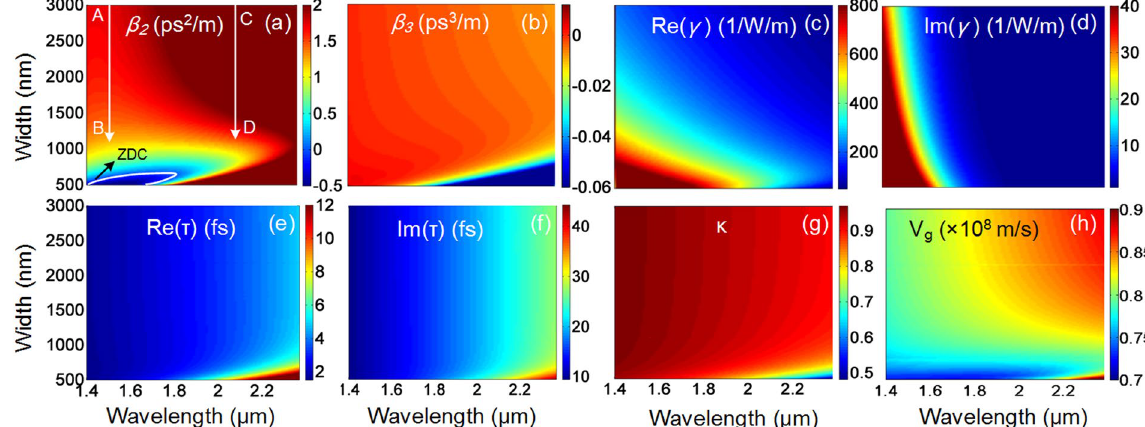
Figure 2. The variations of ( a ) β 2 , ( b ) β 3 , ( c ) real part of γ , ( d ) imaginary part of γ , ( e ) real part of τ , ( f ) imaginary part of τ , ( g ) confinement factor κ , and ( h ) group velocity v g versus the wavelength and taper width.